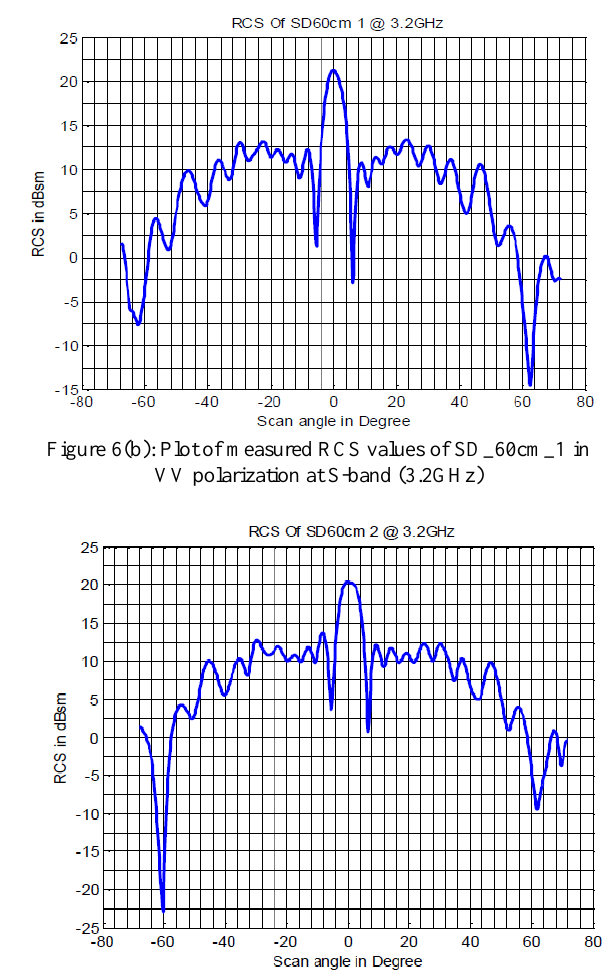
Figure 6(c): Plot of measured RCS values of SD_60cm_2 in VV polarization at S-band